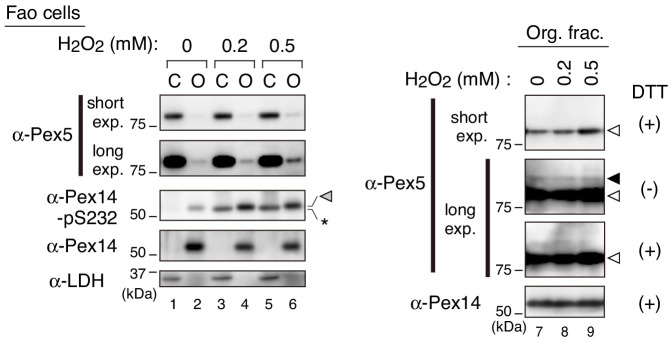
Pex5 recycling upon H2O2-treatment.Fao cells treated with H2O2 at indicated concentration for 1 hr were homogenized in the presence 5 mM NEM. PNS fractions were separated into the cytosolic (C) and organelle (O) fractions. Equal aliquots of the cytosolic and organelle fractions in Laemmli sample buffer with 0.1 M DTT (left panels) and the organelle fractions in the presence (+) or absence (-) of DTT (right panels) were analyzed by SDS-PAGE and immunoblotting with indicated antibodies. Gray, solid, and open arrowheads indicate phosphorylated Pex14 at S232, mono-ubiquitinated Pex5 at Cys11 (Okumoto et al., 2011), and unmodified Pex5, respectively. *, a nonspecific band.